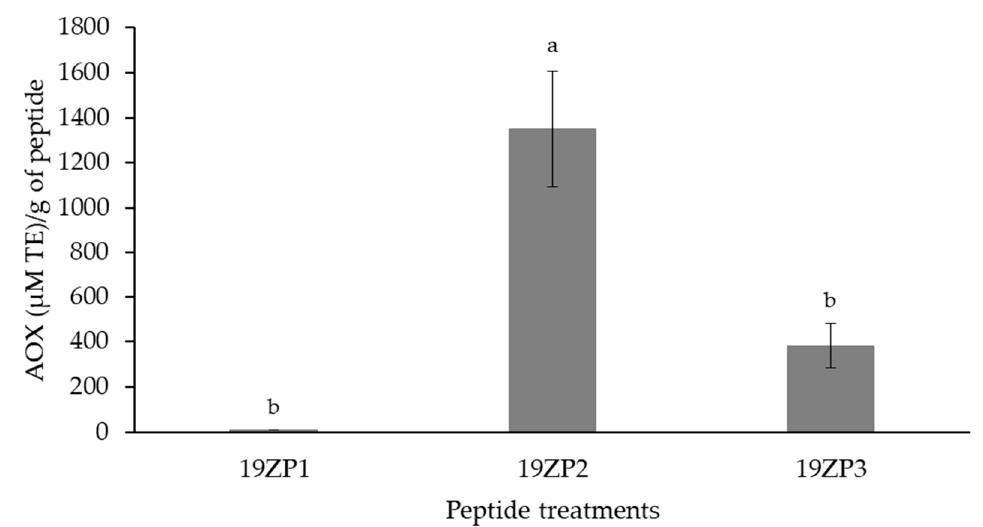
Figure 6. Evaluation of the antioxidant capacity (AOX) of the peptides using the oxygen radical absorbance capacity (ORAC) assay. Results are expressed as mean values ± standard deviation; n = 3. Superscript letters represent statistical differences among samples. Statistical difference was determined by Tukey’s test ( p < 0.05). TE: Trolox equivalents